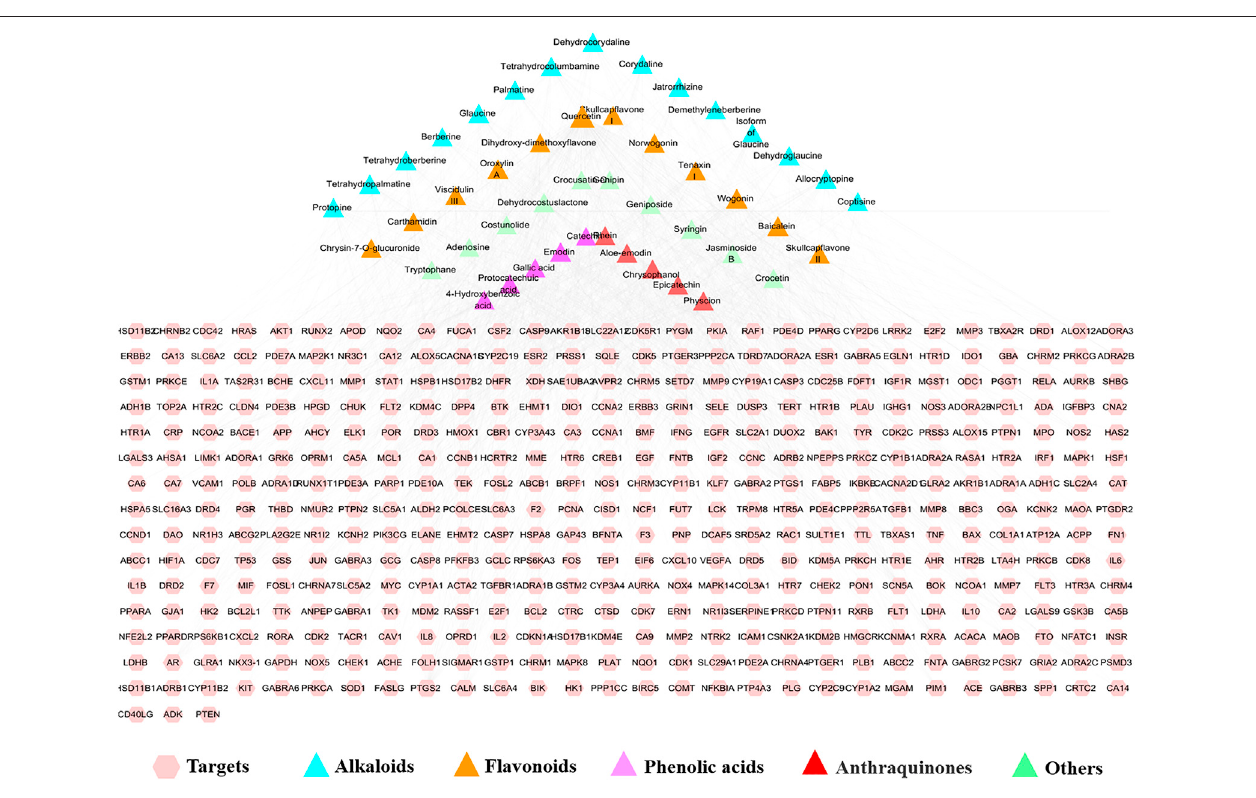
Frontiers in Pharmacology |